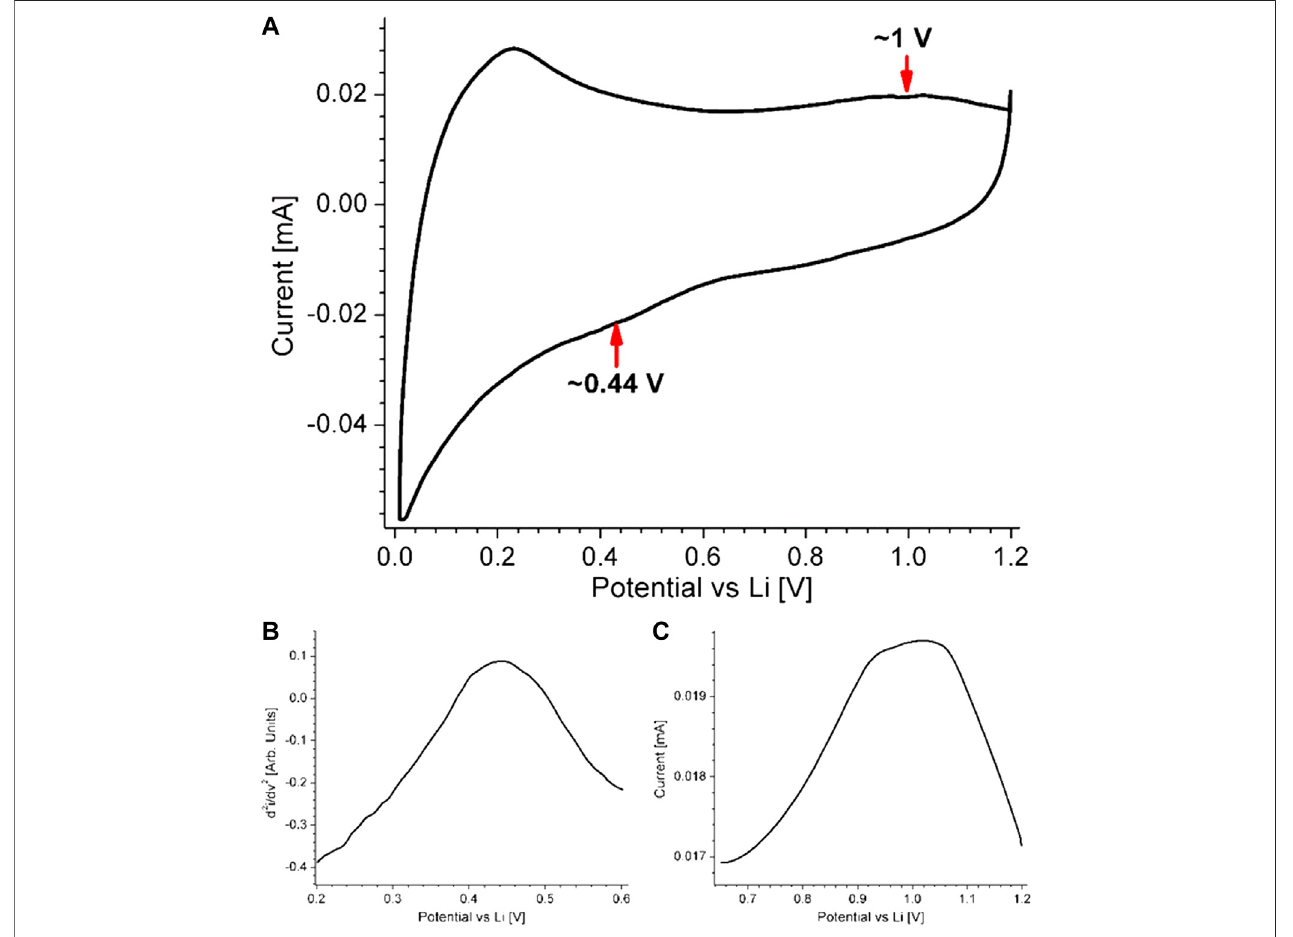
FIGURE 7 | A) Cyclic voltammogram of a half battery cell with Mx-Onyx-950C as working electrode. (B) Second derivative of the lithiation section of the curve, to denote the in fl ection point at 0.44 V. (C) Zoom in at the delithiation region of the curve to denote the peak at around 1 V.